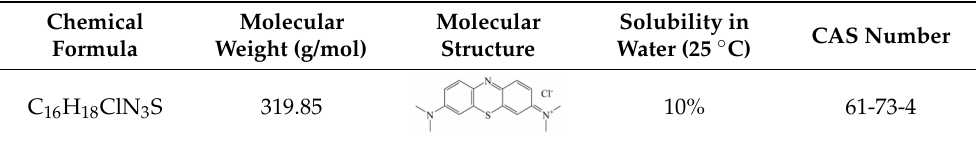
Table 1. Principal MB chemical and physical